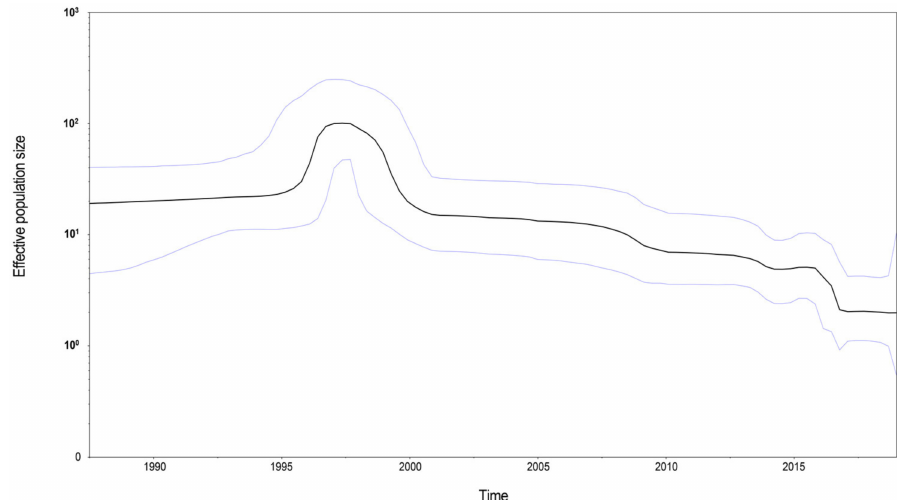
Figure 5. Bayesian skyline plot of MeV genotype B3’s H gene for all selected strains. The Y -axis and X -axis indicate the effective population size and the time (year), respectively. Mean effective population is displayed as a black line. The 95% highest posterior densities are shown as light blue